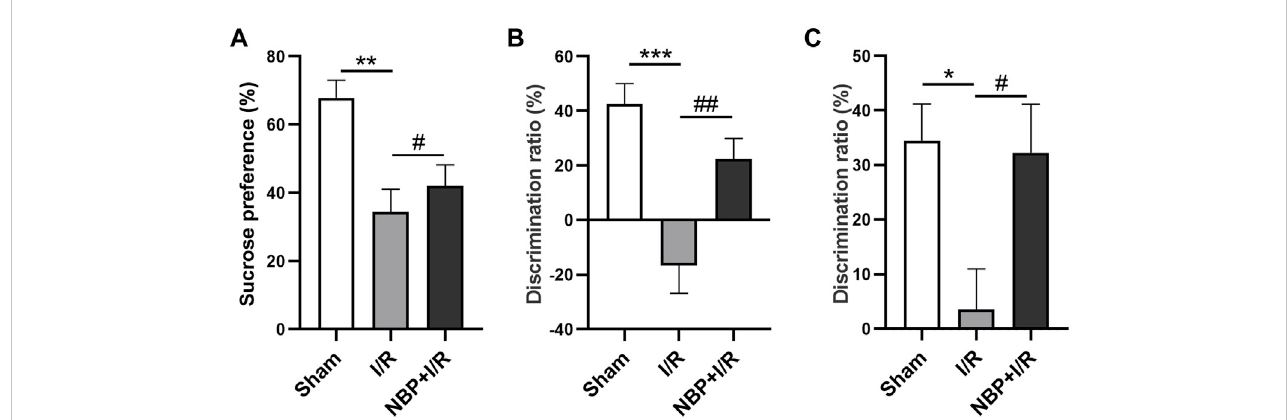
FIGURE 3 Effects of NBP on the cognitive behavior of I/R rats. (A) Effects of NBP on depression-like behavior in I/R rats as assessed by the SPT. Sucrose consumption was signi fi cantly decreased in I/R rats, while NBP signi fi cantly enhanced sucrose preference. (B) Effects of NBP on social cognition in I/R rats by SItesting.Thediscriminationratiowassigni fi cantlydecreasedintheI/Rgroupandsigni fi cantlyincreasedafterNBPtreatmentontheSItest. (C) EffectsofNBP on study and memory in I/R rats by the NOR test. The discrimination ratio was signi fi cantly decreased in the I/R group and signi fi cantly increased after NBP treatment on the NOR test. Data are expressed as the mean ± SEM (n = 10) and were analyzed by one-way ANOVA ( post hoc analysis: Tukey ’ s post hoc analysis test). * ( p < .05), ** ( p < .01) and *** ( p < .001) represent signi fi cance compared to the sham group. # ( p < .05) and ## ( p < .01) represent signi fi cance compared to the I/R group ( p < .01). NBP dose: NBP + I/R, 9